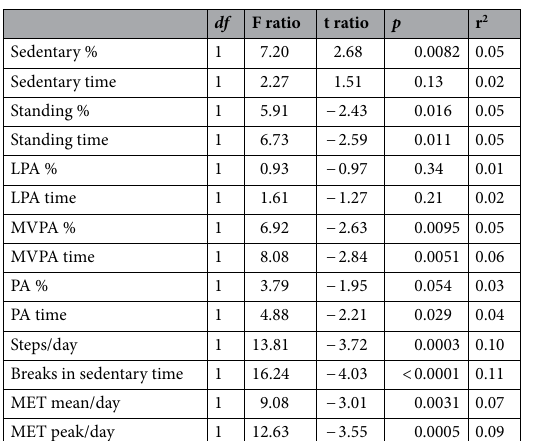
Table 2. Associations between BMI and accelerometer measures, least squares effect tests with sex and age included in the model. LPA light physical activity, MVPA moderate to vigorous physical activity, PA physical activity (LPA and MVPA together), MET the metabolic equivalent.